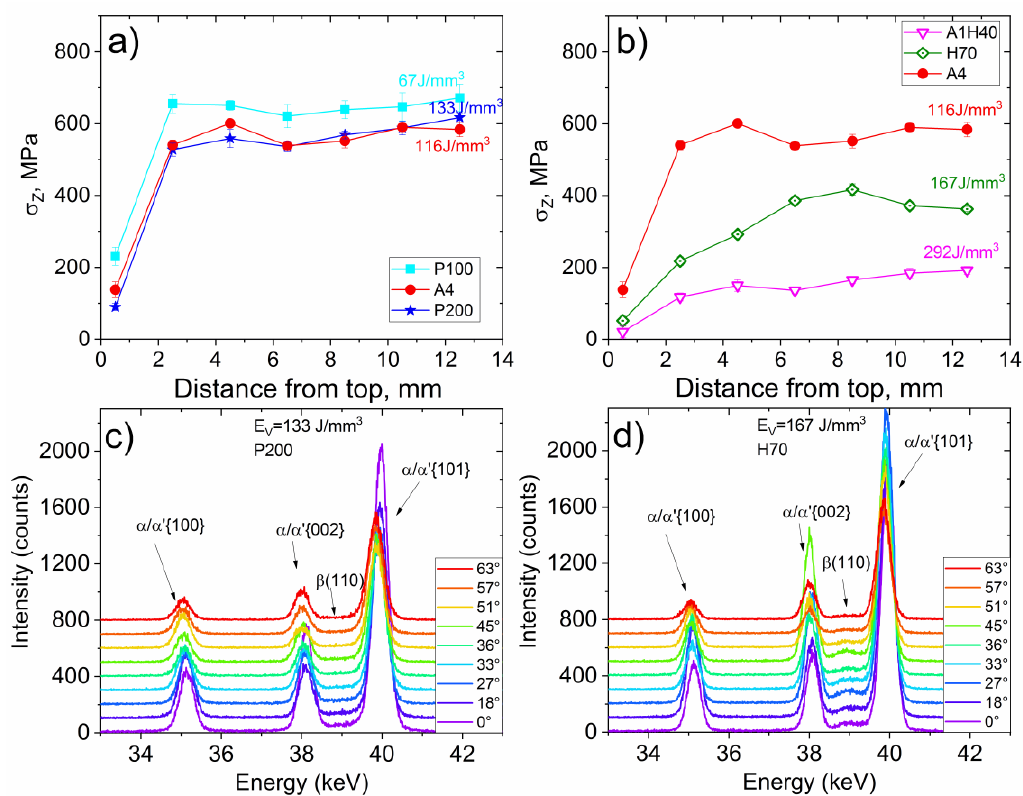
Figure 8. RS along the building direction for ( a ) laser power variation study, ( b ) hatch distance variation study; diffractograms for ( c ) P200 sample; ( d ) H70 sample (the ψ -tilt angles are indicated in the insets).